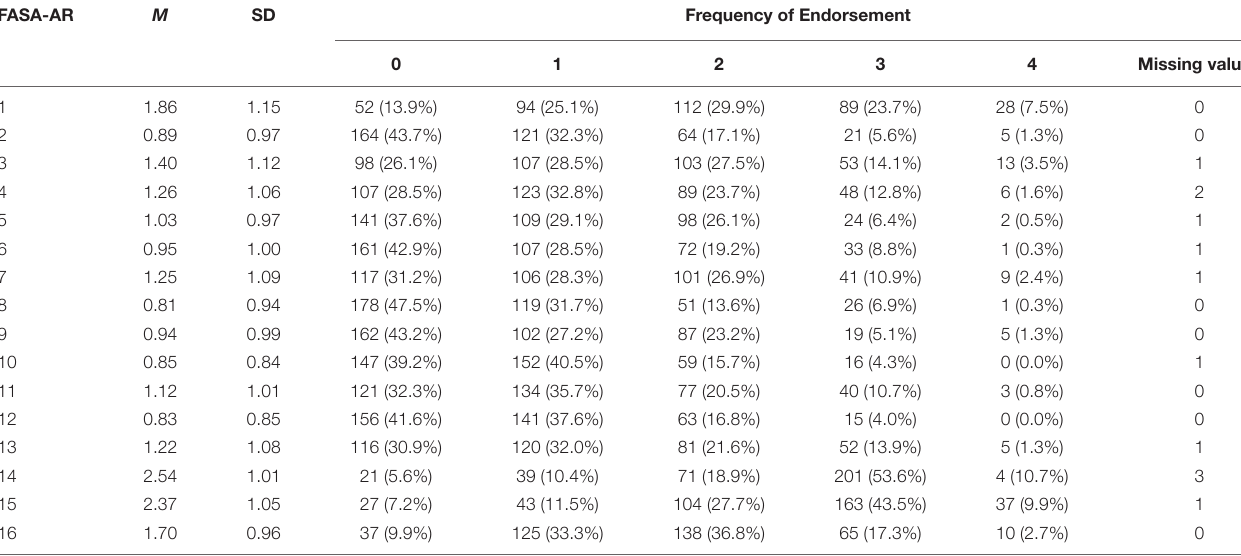
TABLE 3 | Individual items endorsed on the Family Accommodation Scale Anxiety—Adult Report.